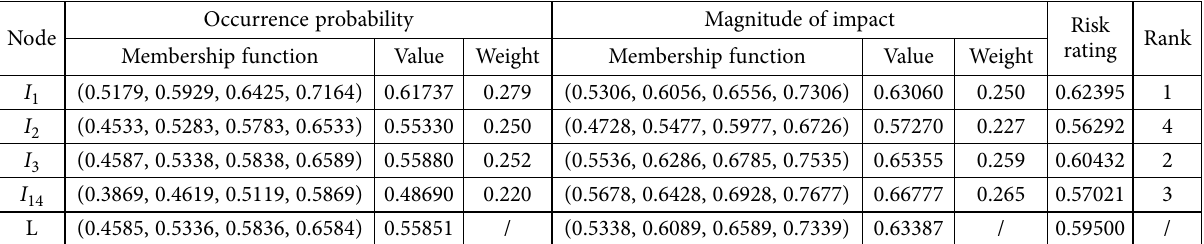
Table 8. RA results of risk groups in the third level and the overall project risk for the Ankara-Istanbul high-speed railway project Node